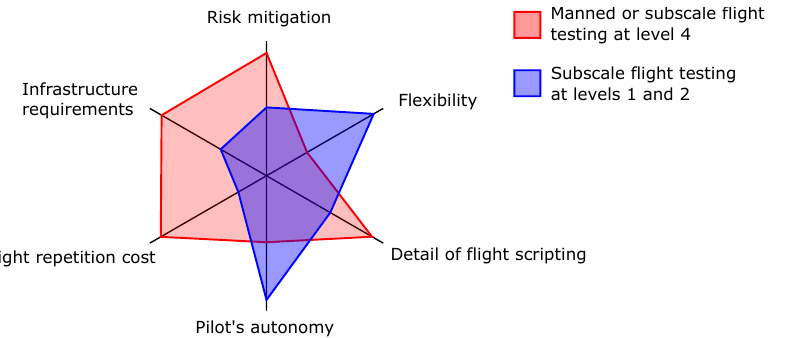
Figure 7. Conceptual representation of some of the differences between planning manned flight testing and subscale flight testing with relatively small